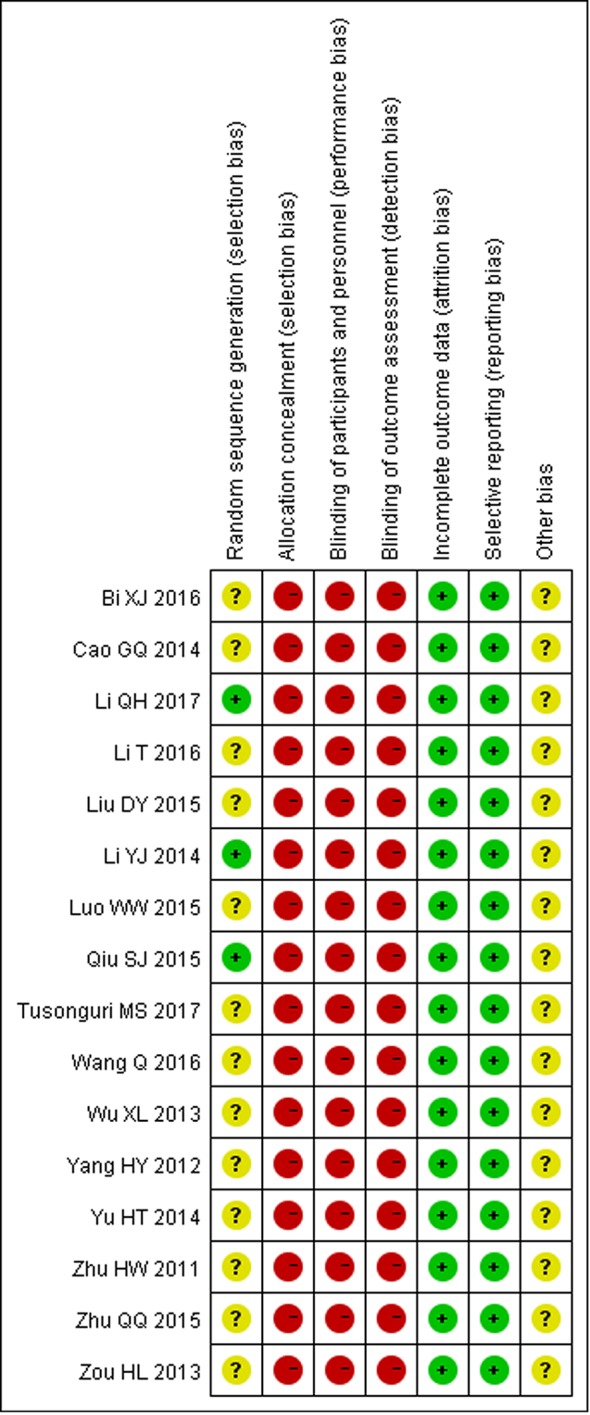
Risk of bias summary.